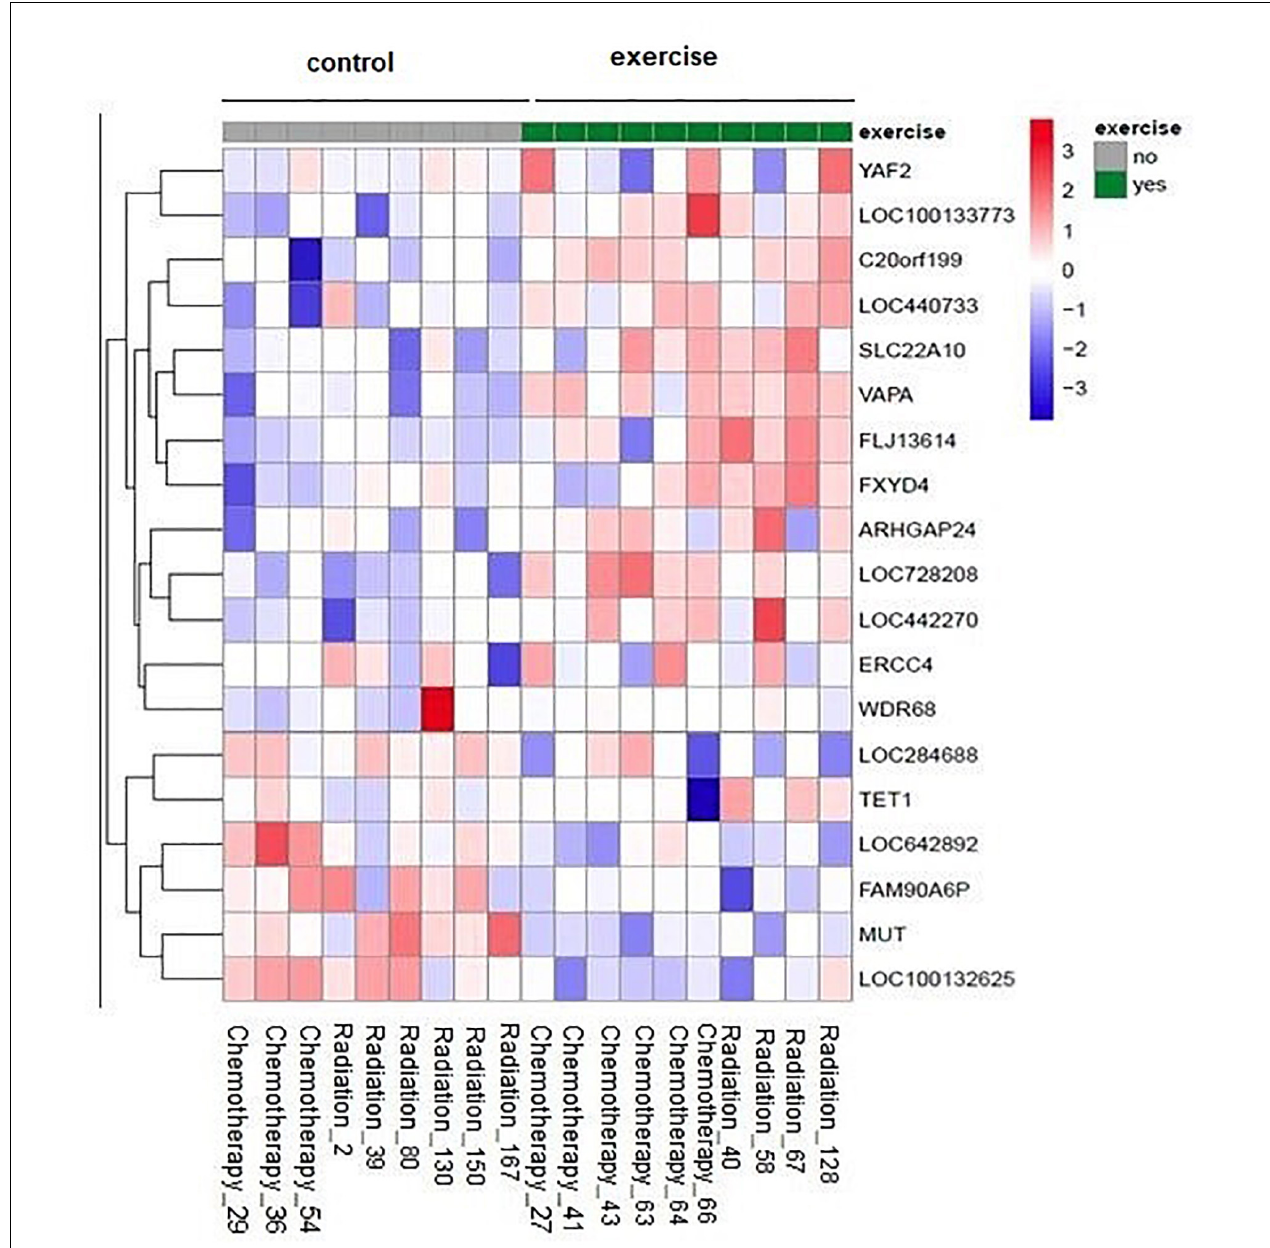
FIGURE 1 | Impact of physical exercise on NK cell gene expression: The heat map represents the scaled expression levels of genes with raw p < 0.001. The rows represent genes identified by the name on the right of the figure. The individual patient samples are shown as columns (1 column per sample). The color red represents high expression, while blue represents low expression. The heat map is combined with clustering where genes are grouped together based on the similarity of their gene expression